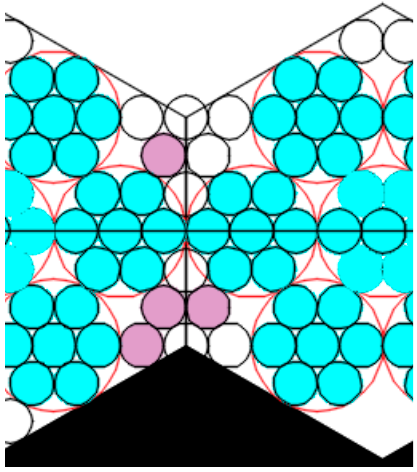
Figure 12. An illustration of deformation compaction of the structure at the boundary of two small regular hexagons.